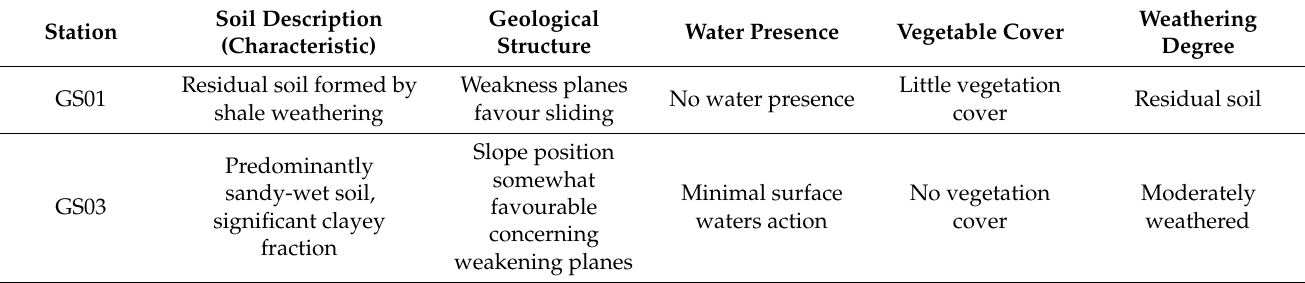
Table 12. Description of geomechanical soil